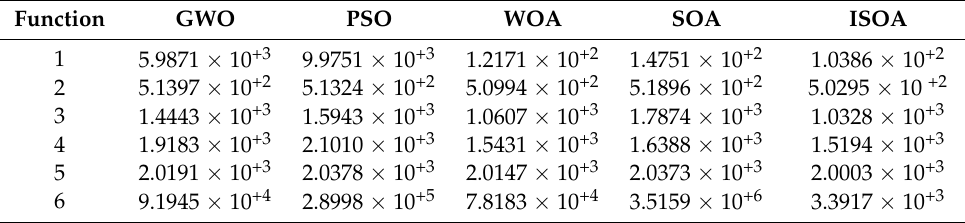
Table 4. CEC-2017 function test results.